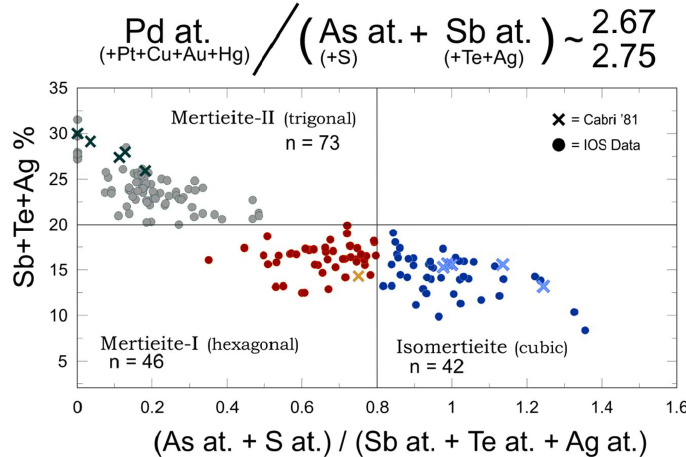
Figure 10. The graph depicts the classification of palladium arseno-antimonides species of the platinum-group minerals belonging to the isomertieite-mertieite series. The elemental values are presented in atomic proportions (at.). Data from Cabri [25] have been included to help establishing the limits between the isomertieite, mertieite-I, and mertieite-II fields.